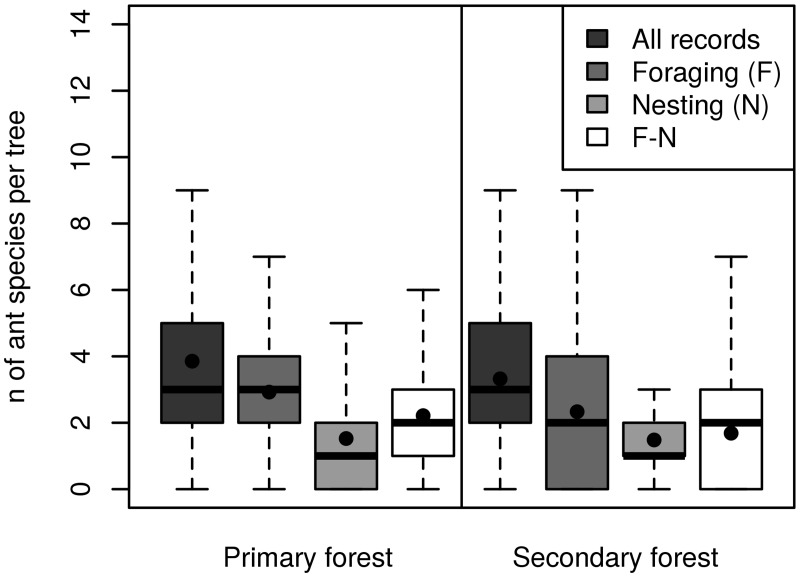
Number of ant species per tree in primary and secondary forest plot.Box-plots show median and mean values per a tree (black line and dot respectively) with 25–75% quartiles and whiskers represent 1.5 interquartile ranges for all species combined (All records), foraging species (F), nesting ant species (N) and species that foraged but did not nest on tree (F-N). Average species richness per tree is significantly higher for F than for N ants in both habitat types (paired t-test, log-transformed data, P < 0.001). See also Table 2 for the mean and SE values.